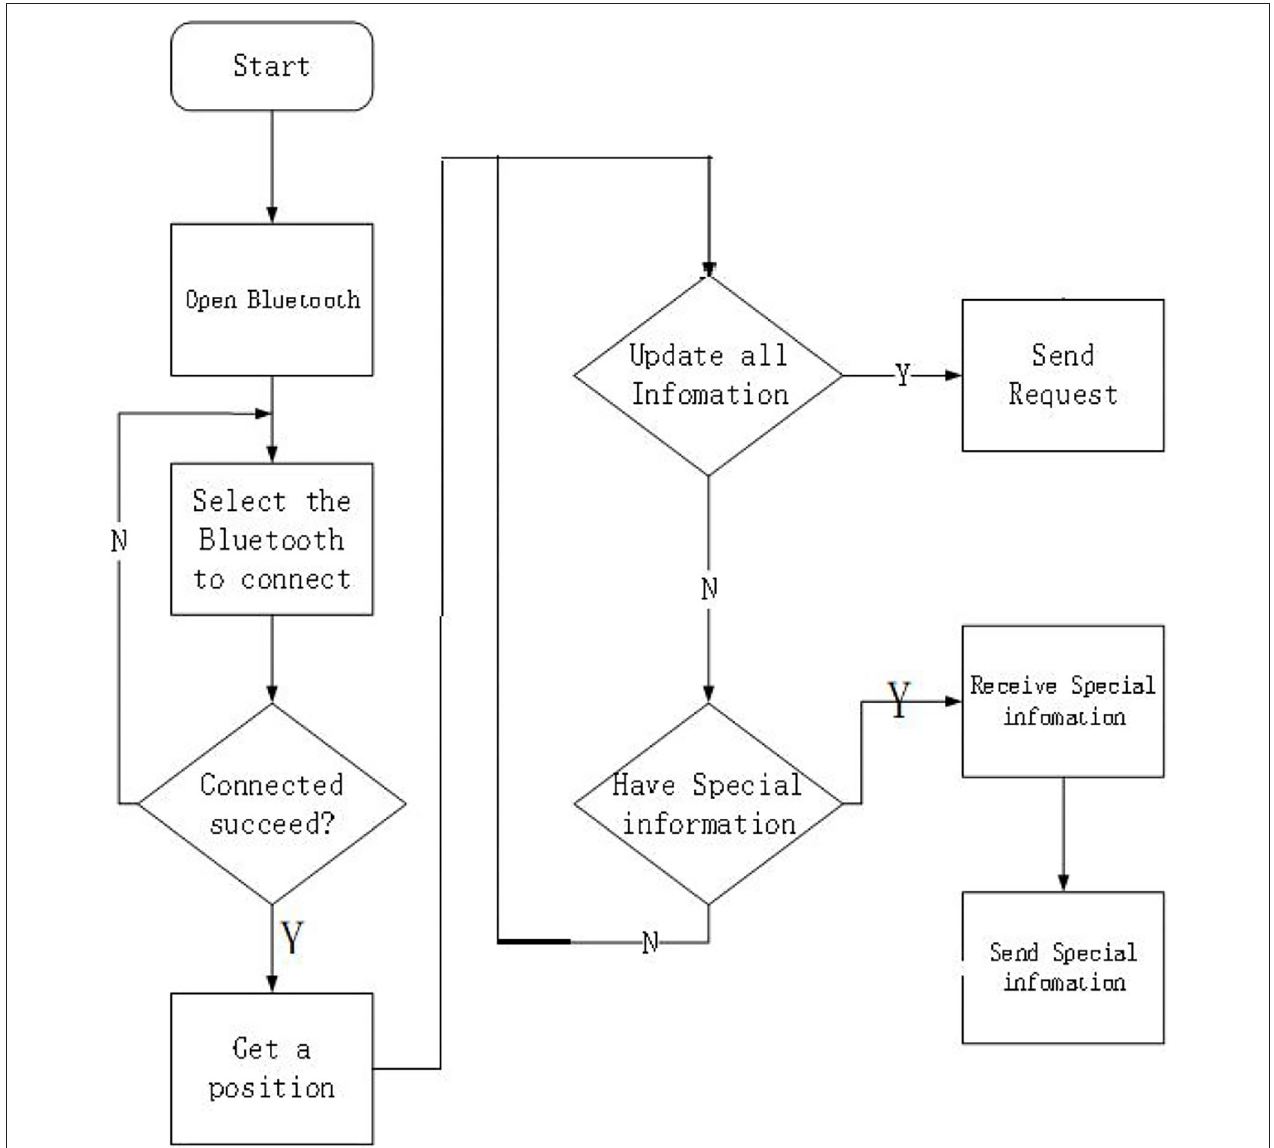
FIGURE 3 | Android client system